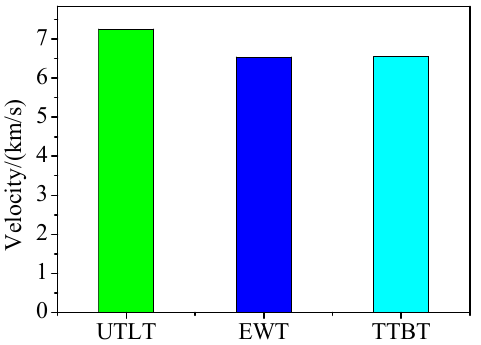
Figure 15. At 50 µ s time head velocity of jet. Figure 15. At 50 μ s time head velocity of jet.